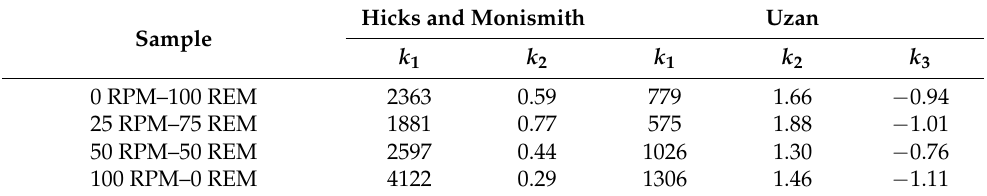
Table 2. Regression parameters of Hicks and Monismith’s and Uzan’s models.